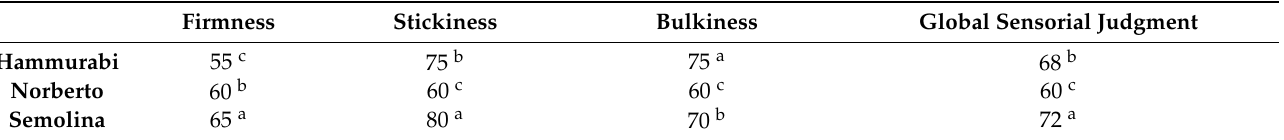
Table 4. Sensory assessment of einkorn cv Hammurabi and cv Norberto and semolina cooked pasta.